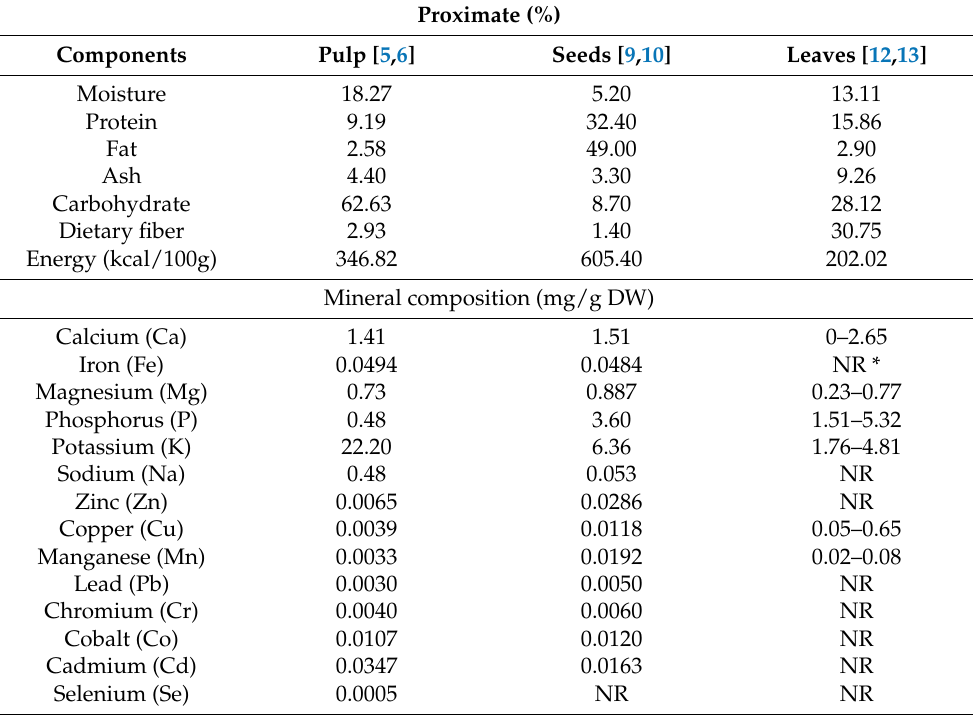
Table 1. Nutritional and mineral composition of desert date pulp, seeds and leaves.